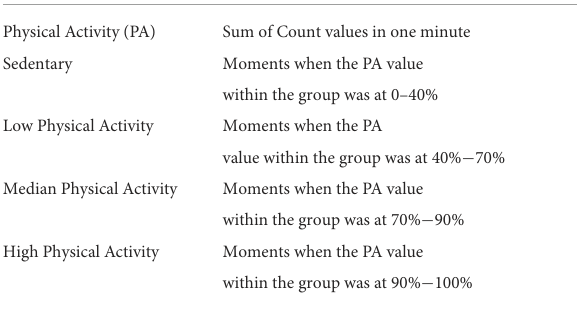
TABLE 1 Analysis indicators and definition criteria of daytime physical activity